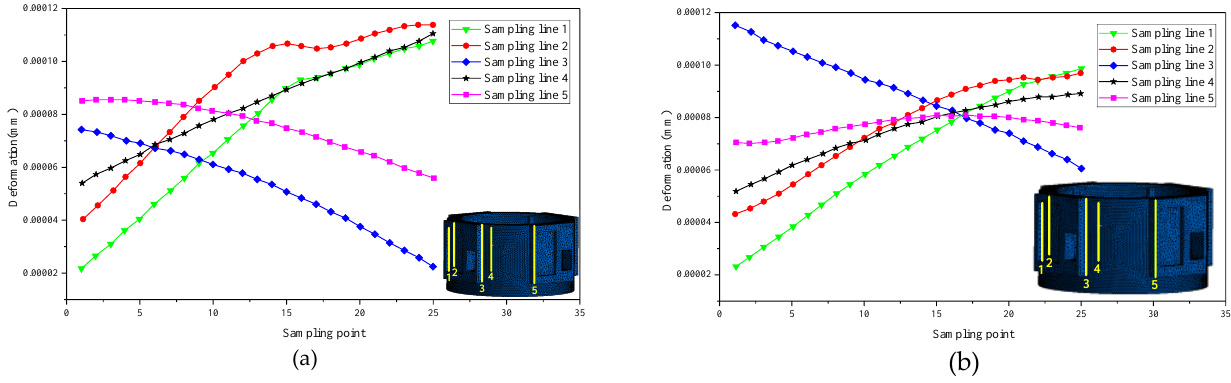
Figure 5. Deformation of each sampling line. ( a ) Deformation of each sampling line in clamping strategy 1; ( b ) deformation of each sampling line in clamping strategy 2.